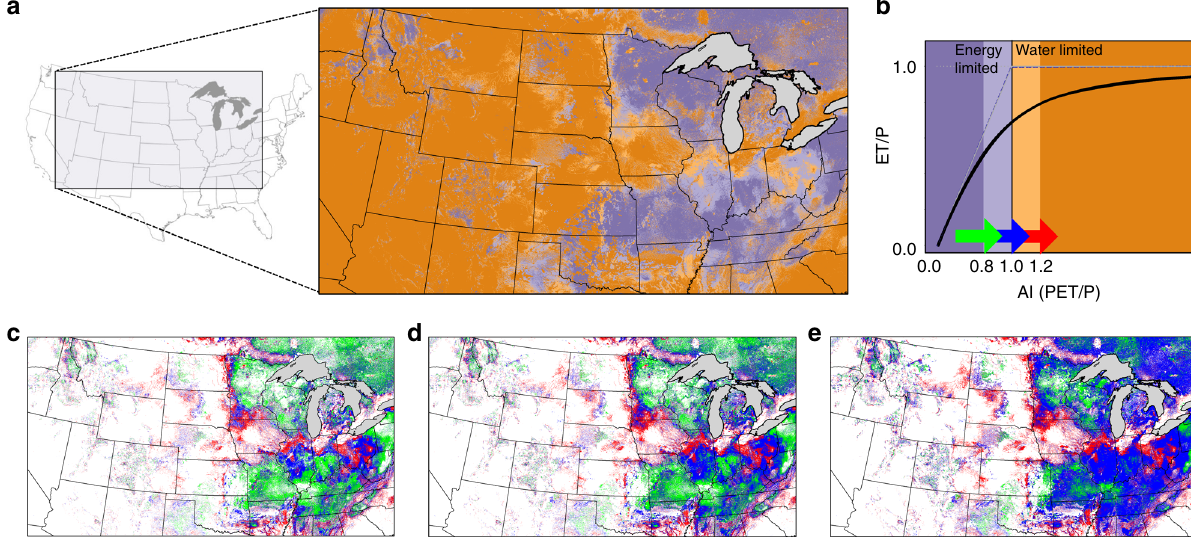
Fig. 1 Warming increases aridity and shifts water and energy limits of Evapotranspiration. a Map of Baseline aridity index (AI) classi fi ed as strongly water limited (dark orange), weakly water limited (light orange), weakly energy limited (light purple), and strongly energy limited (dark purple). Shifts between AI classi fi cations for the 1.5 °C ( c ) 2 °C ( d ) and 4 °C cases ( e ) (color legend shown with the arrows on b ). The Budyko relationship between AI and evaporative fraction ( b ) (solid black line), plotted relative to the water (Evapotranspiration (ET)/Precipitation (P) = 1) and energy (Evapotranspiration (ET) = Potential Evapotranspiration (PET)) absolute limits (dashed blue